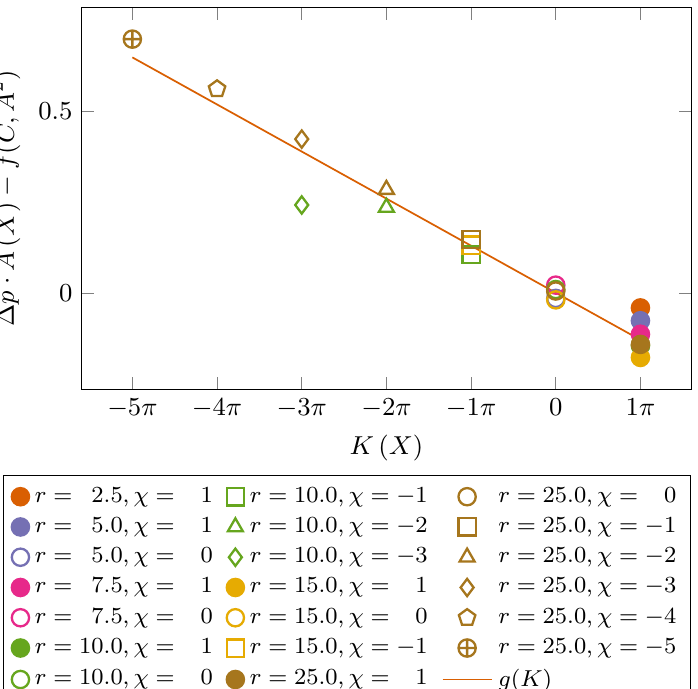
Figure 7. Dimensionless pressure difference between capillary condensation pressure and bulk phase transition pressure times the surface area Minkowski functional minus the function from Figure 6, ∆ p · A ( X ) − f ( C 3/4 , A 1/2 ) , as a function of the Minkowski functional, K ( X ) . The graph shows a collapse of the data and a linear fit with: g ( K ) = κ (cid:48)